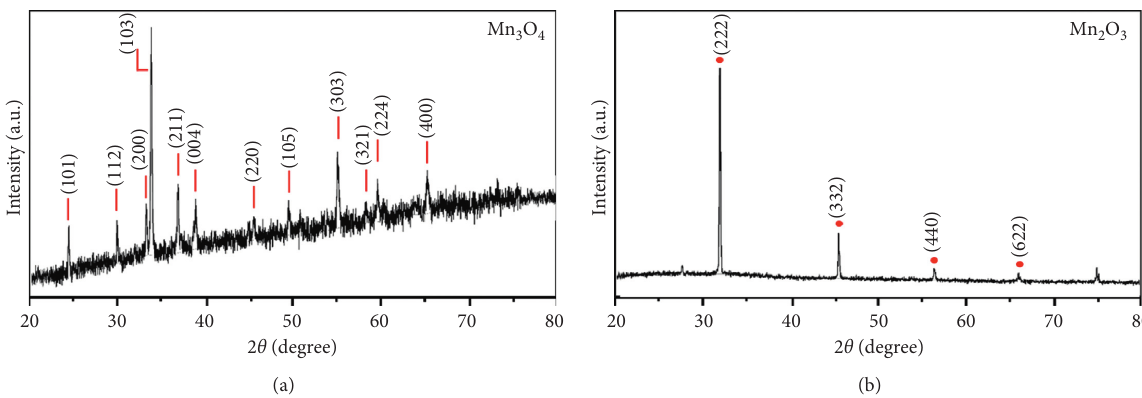
Figure 4: XRD spectra of manganese oxide nanoparticles obtained from (a) calcination and (b) chemical treatment. The identity of the Mn 2 O 3 is still ambiguous as some of the characteristic peaks belonging to the spinal structure of Mn 2 O 3 are missing from the